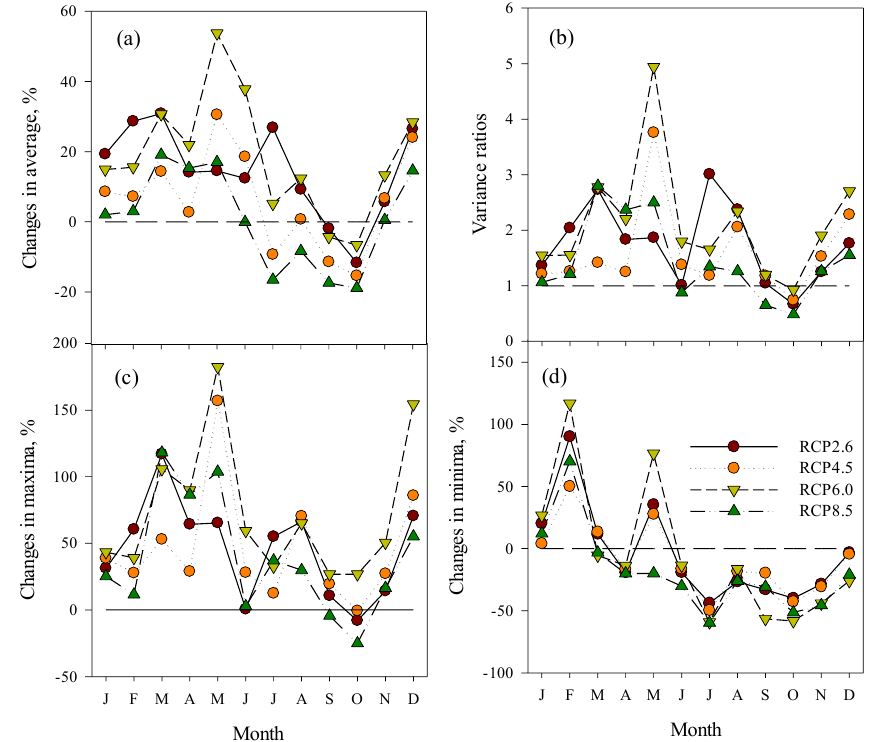
Figure 7. Changes in average and variability of monthly streamflow during 2011–2040 relative to 1961–2005.